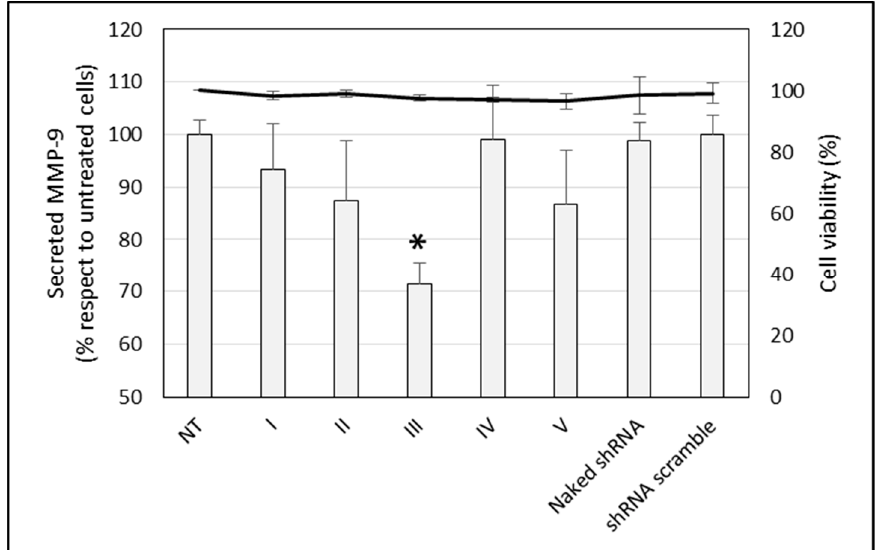
Figure 4. The secreted MMP-9 levels (bars, expressed as a percentage with respect to untreated cells) and viability (line) of HCE-2 cells treated with the vectors and naked p-shRNA-MMP-9. Data are expressed as mean ± SD of 4 experiments. NT: non-treated cells. * p < 0.05 with respect to NT cells.